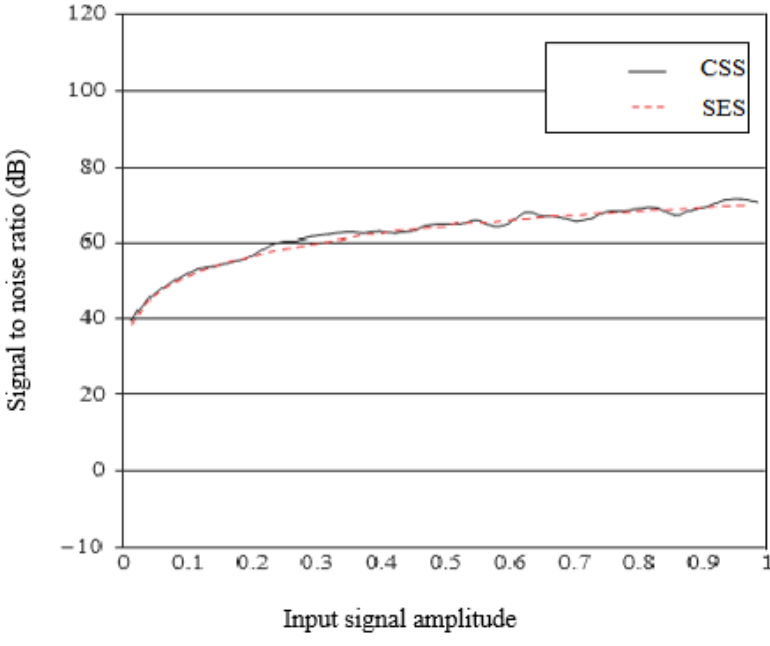
Figure 13. Signal to noise ratio of SES vs. CSS.